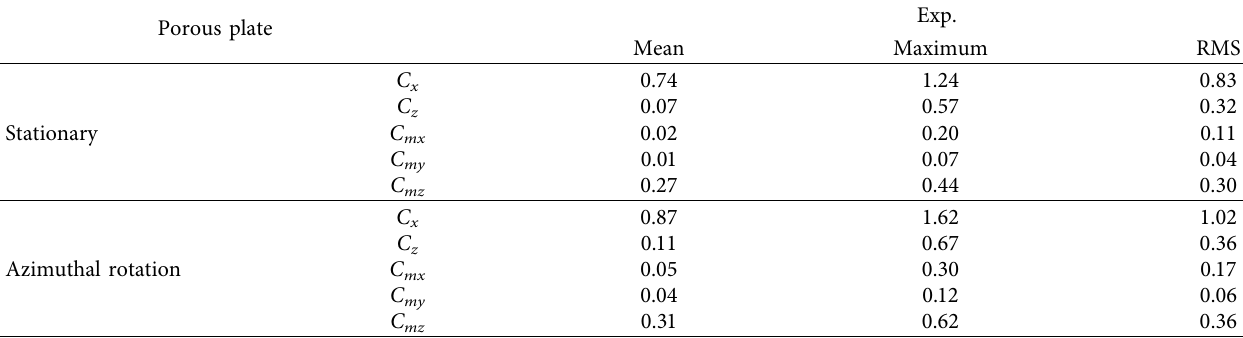
Table 4: The mean, maximum, and RMS values of aerodynamic coefficients for the porous plate antenna when the antenna is stationary and azimuthal rotation (the direction is not included in these results). Exp. Porous plate Mean Maximum RMS C x Stationary C x Azimuthal rotation